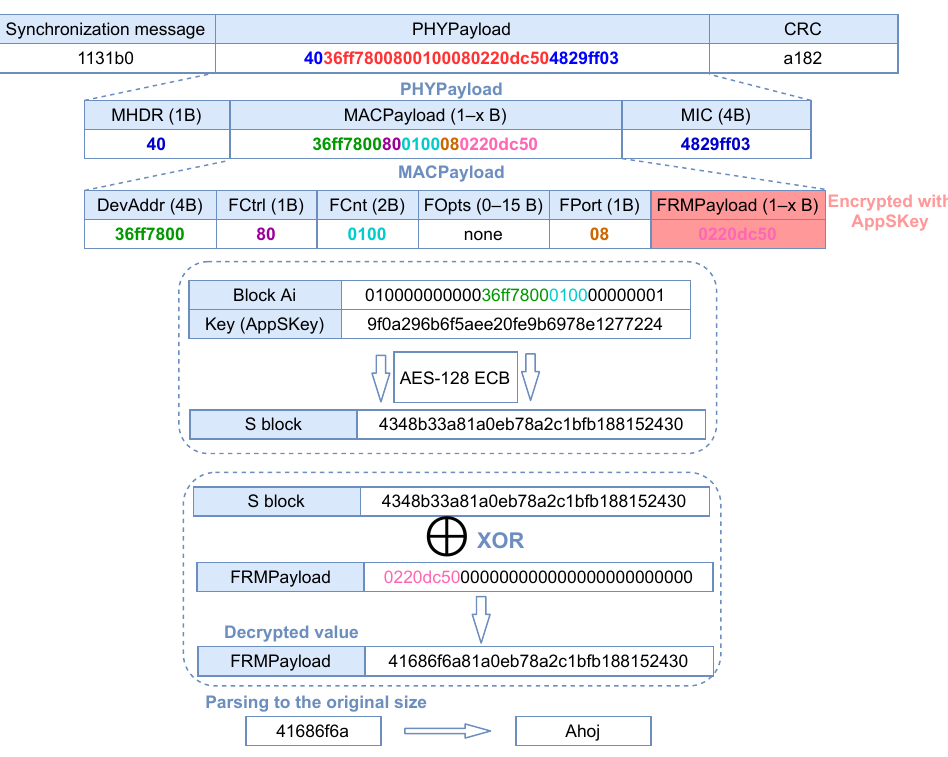
Figure 12. LoRaWAN message